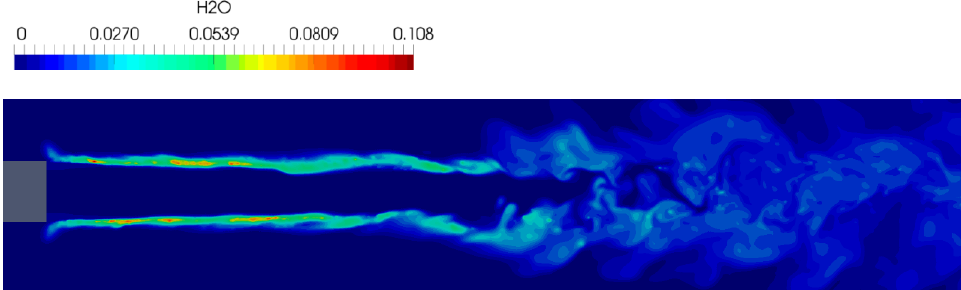
Figure 7. Injected parcels of water: ( a ) velocity; ( b ) temperature.